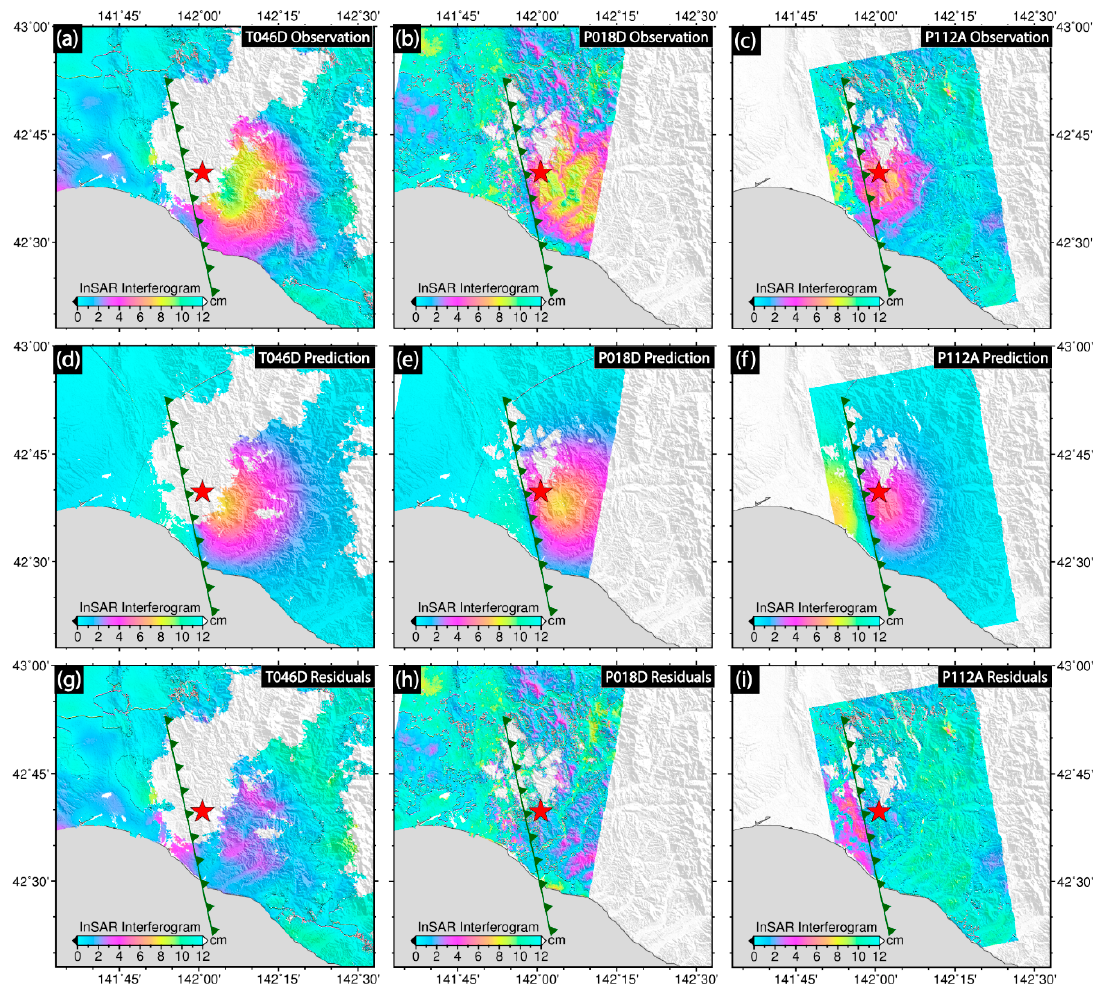
Figure 8. The observations ( a - c ), predictions ( d - f ), and residuals ( g - i ) of the T046D, P018D, and P112A track images based on the distributed slip model. The interferograms are rewrapped with an interval of 12 cm. The red star denotes the epicenter of the main shock. The surface trace of the fault is from the distributed slip model of this study.